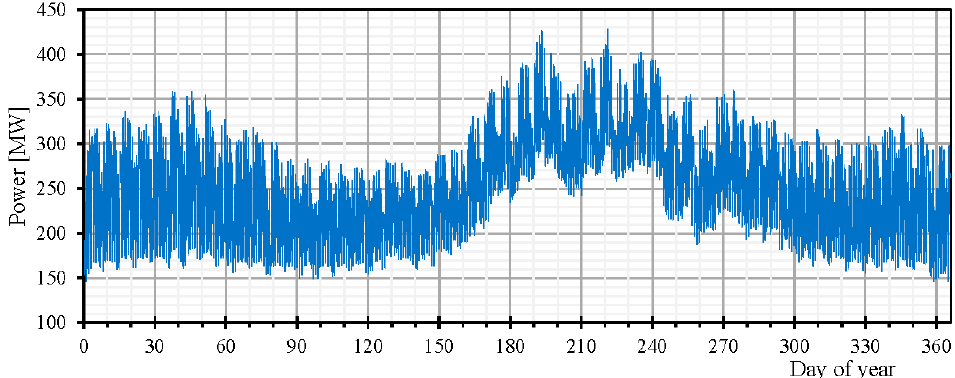
Figure 6. Electrical demand during the year (2012) [20].